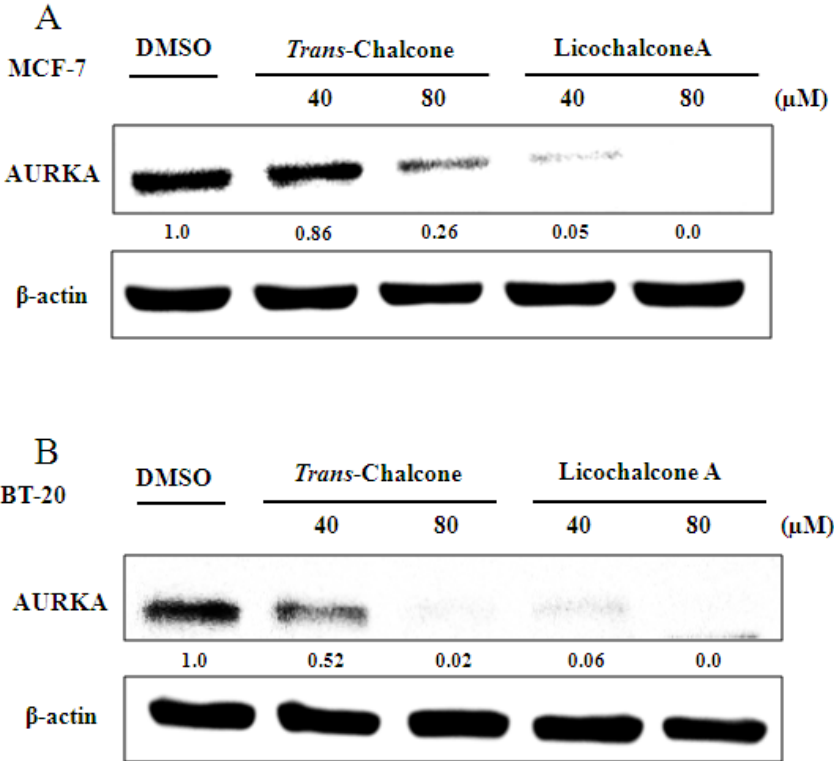
Figure 5. Analysis of chalcones effects at the protein level by western blot for AURKA. ( A ) Expression of AURKA protein in the MCF-7 Cell for both chalcones at different doses; ( B ) Expression of AURKA protein in the BT-20 Cell for both chalcones at different doses.